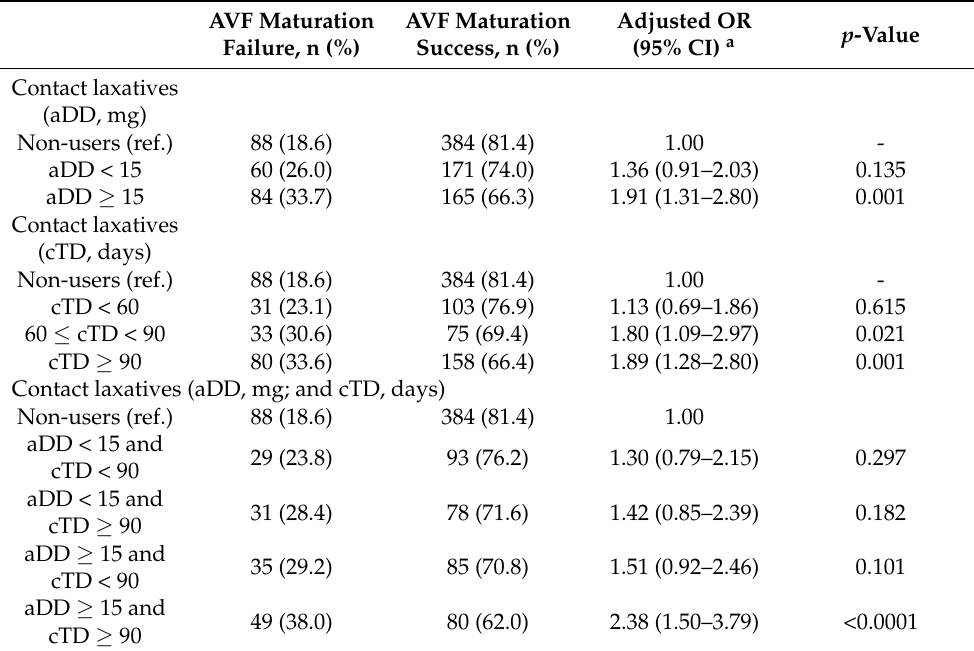
Table 2. The risk of AVF maturation failure is stratified by the average daily dose, the treatment days, and the different doses and treatment duration of contact